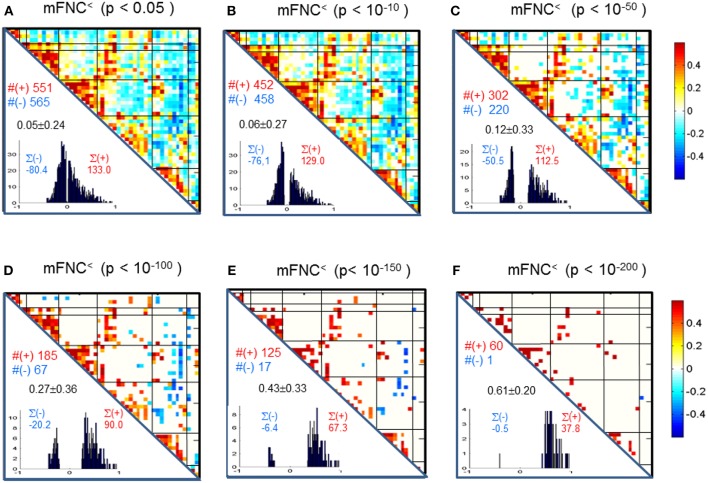
(A–F) Significant connections in group mFNC matrix under p-value thresholding with pthresh = {0.05, 10−10, 10−50, 10−100, 10−150, 10−200}. The numbers of positive and negative connections (denoted by #(+) and #(–) respectively), and the sums of positive and negative connections (denoted by ∑(+) and ∑(–) respectively) were calculated from the survival entries in the pthresh-thresholded matrices (mFNC<).